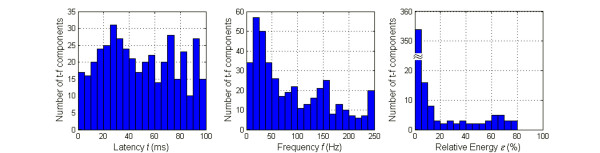
Histograms of MP parameters from 28 SEP signals. The total number of t-f components is 395. The width of latency bin is 5 ms; the width of frequency bin is 12.5 Hz; the width of relative energy bin is 5%.